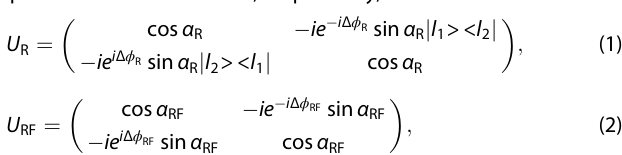
0 is the relative